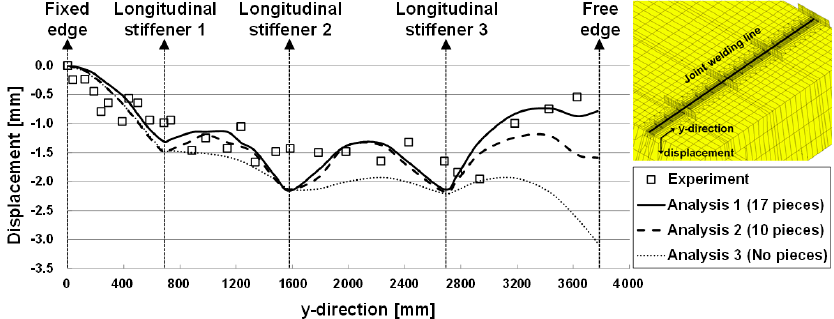
Figure 18. Experimental and analysis results of joint welding deformations for panel block.